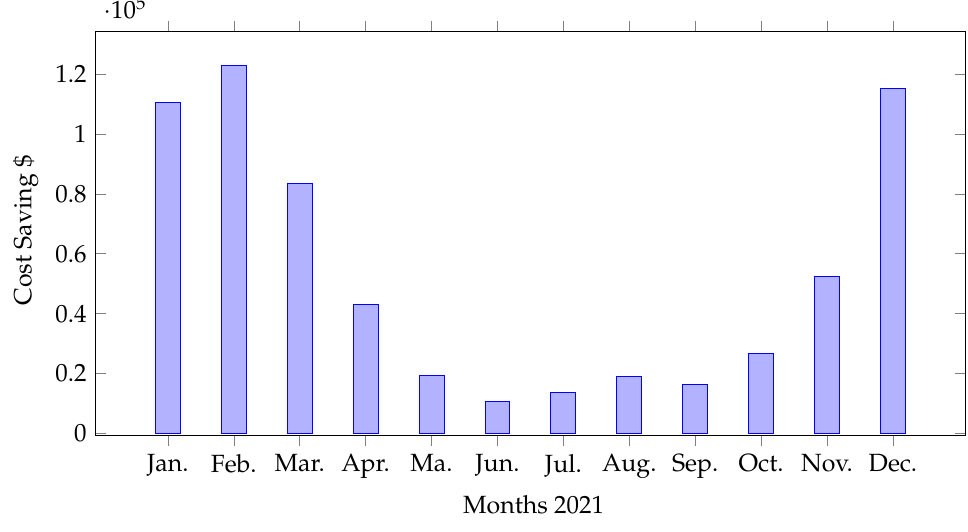
Figure 9. Monthly cost saving for 2021 peak load